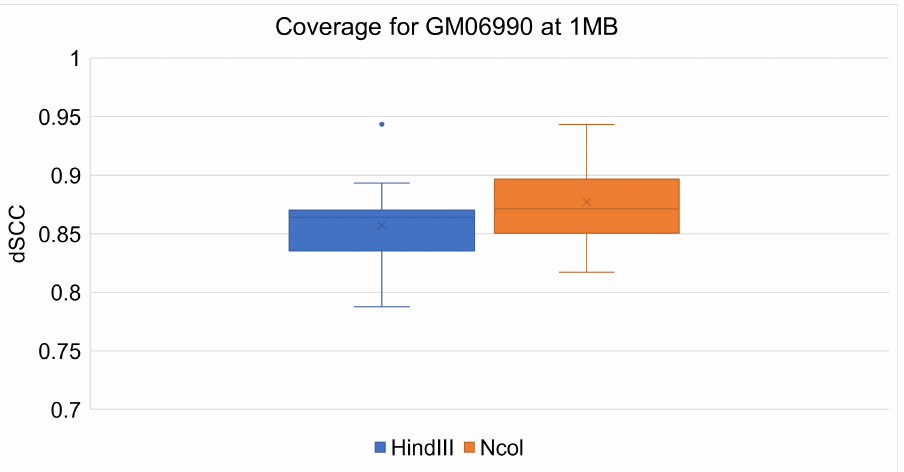
Figure 8. Chromebat’s Performance on the GM06990 at 1 mb for both restriction enzymes HindIII and